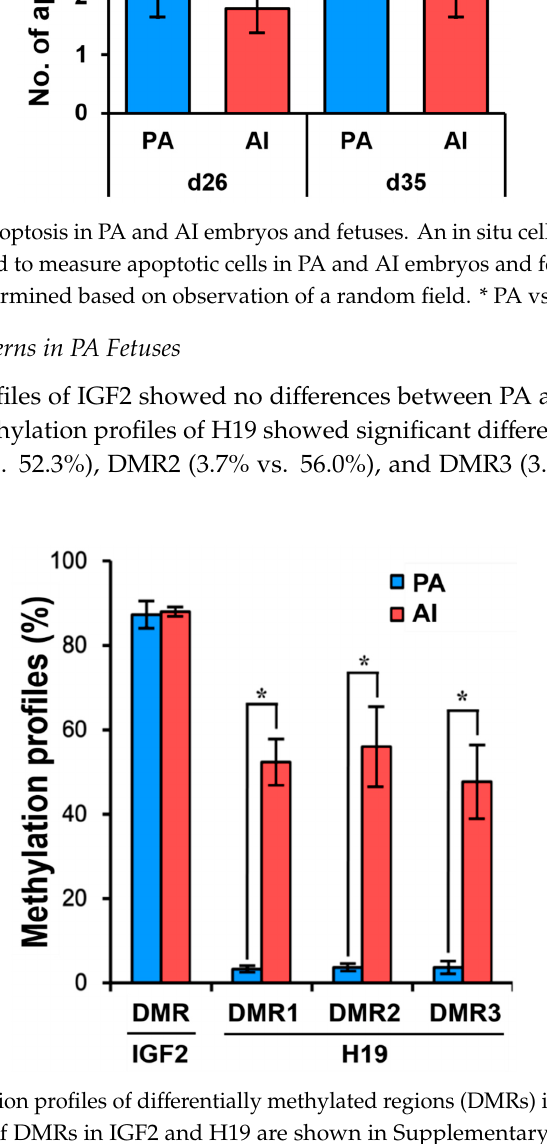
Figure 6 CpG methylation profiles of differentially methylated regions (DMRs) in IGF2 and H19 genes. The relative positions of DMRs in IGF2 and H19 are shown in Supplementary Figure 1. Results shown for PA ( n = 3) and AI ( n = 3) fetuses. The data are shown as means ± SEs of three replicates. * * PA vs. AI ( p < 0.05). PA vs. AI ( p <